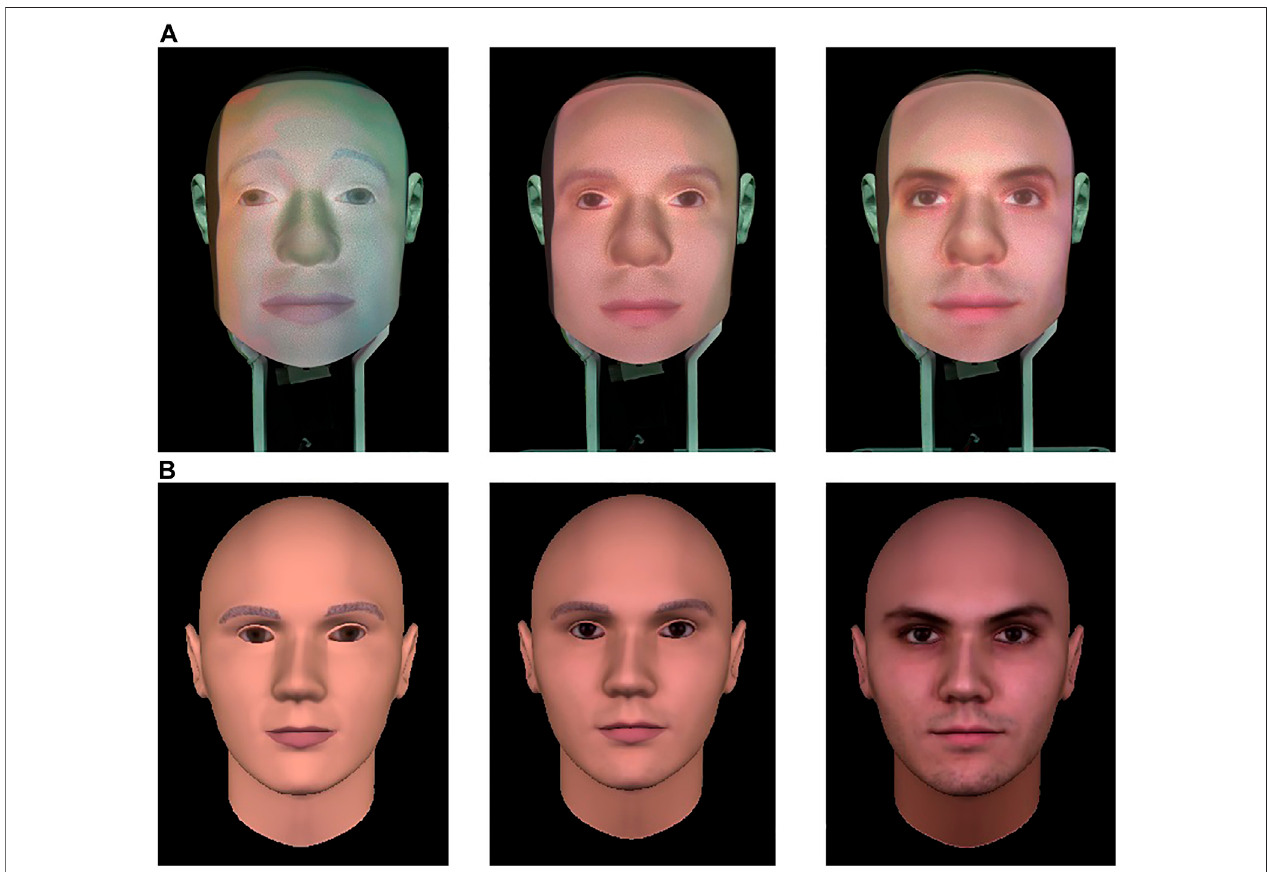
FIGURE 2 | Levels of humanlikeness used in the experiment in the Furhat robot (A) and virtual agent (B) . Left: characterlike; right: humanlike; center: morph.